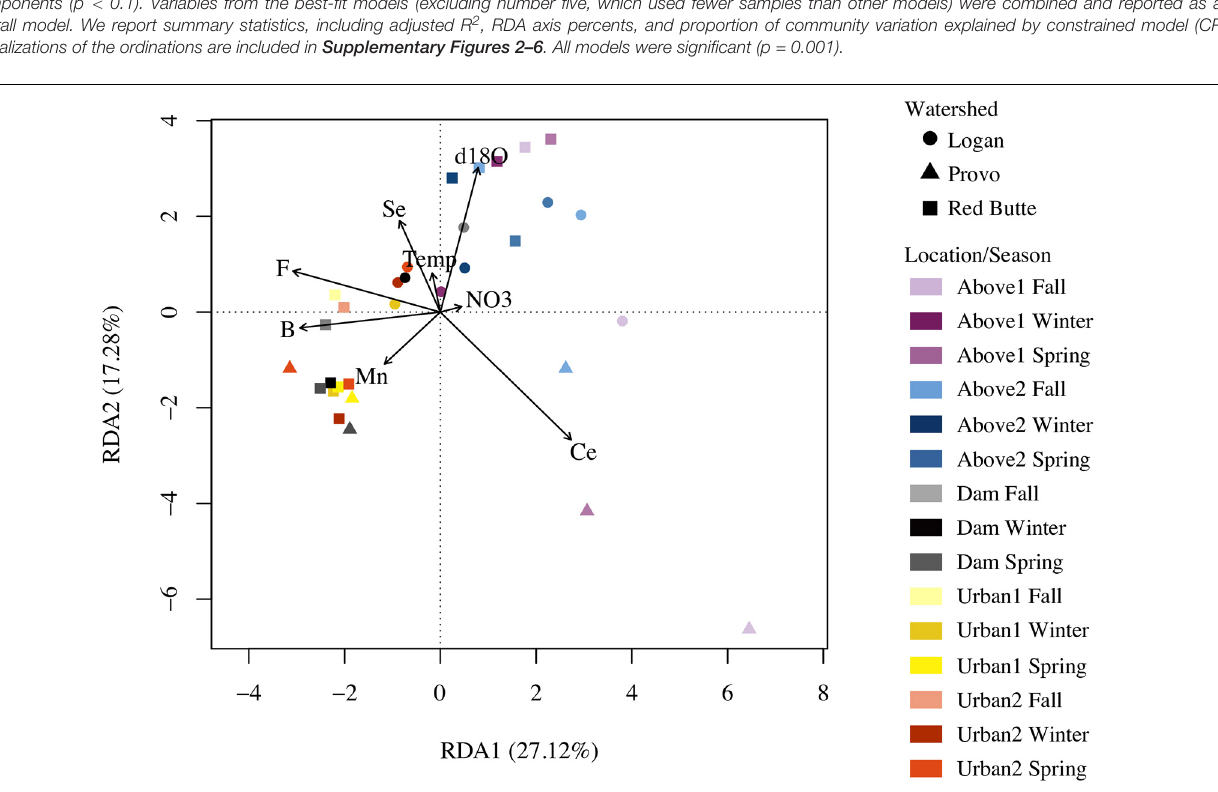
standard field parameters ( R 2 = 0.15, P = 0.001, df = 5, cp = 0.25)